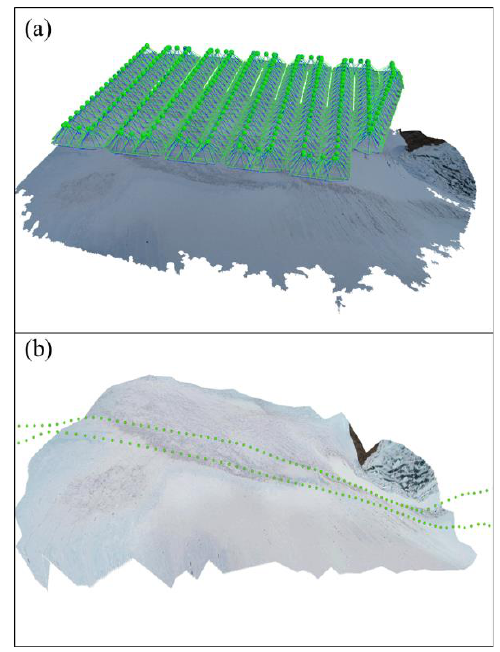
Figure 4 . (a) The initial image position; (b) UAV-derived models and ICESat-2 tracks.